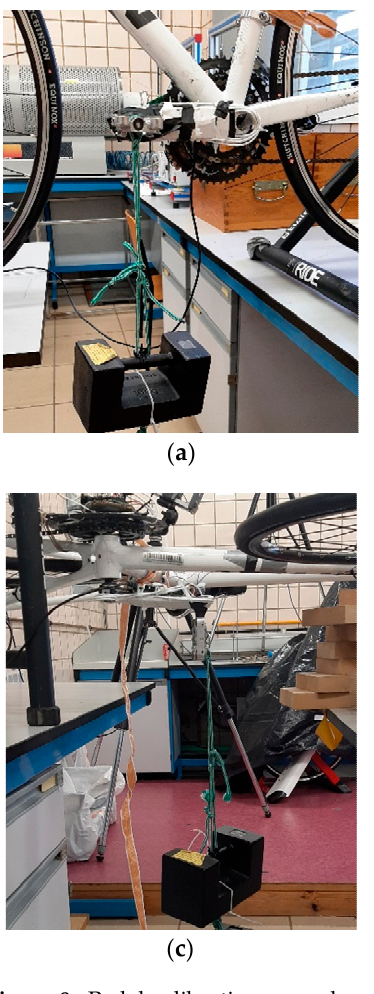
Figure 8. Pedal calibration procedure. ( a ) Tangential direction calibration mounting. ( b ) Radial direction calibration mounting. ( c ) Lateral-medial direction calibration mounting.